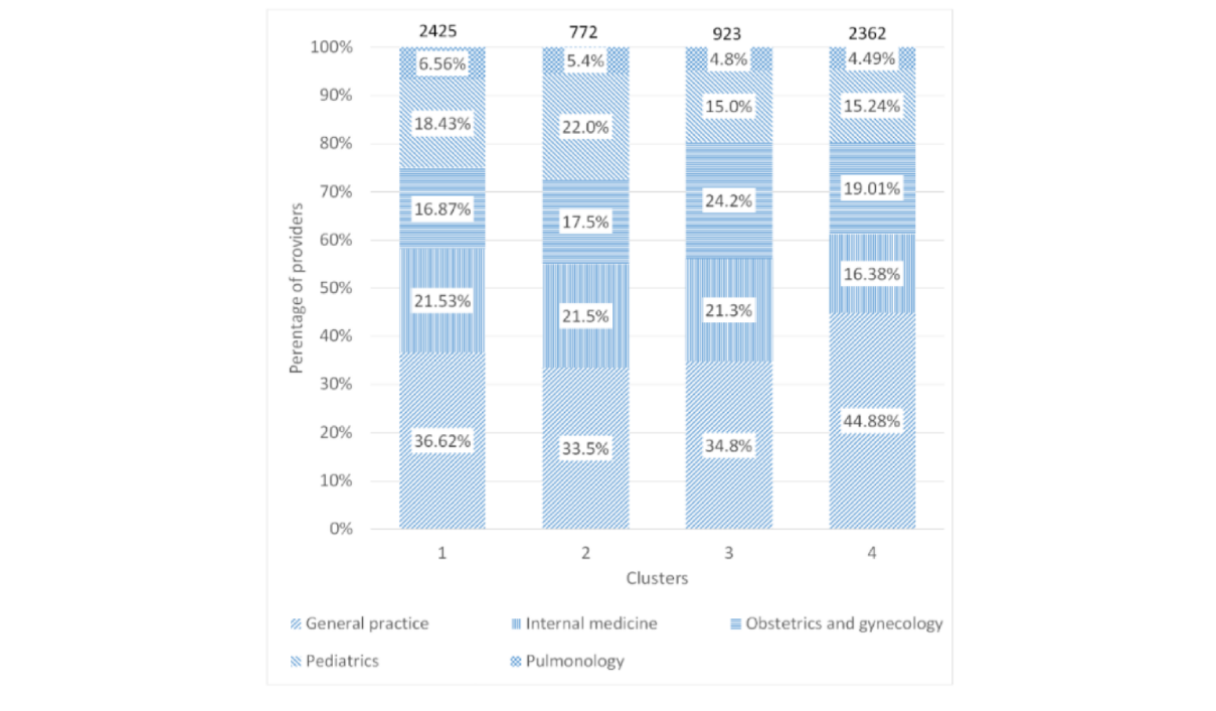
Figure 4. Composition of clusters by specialty.